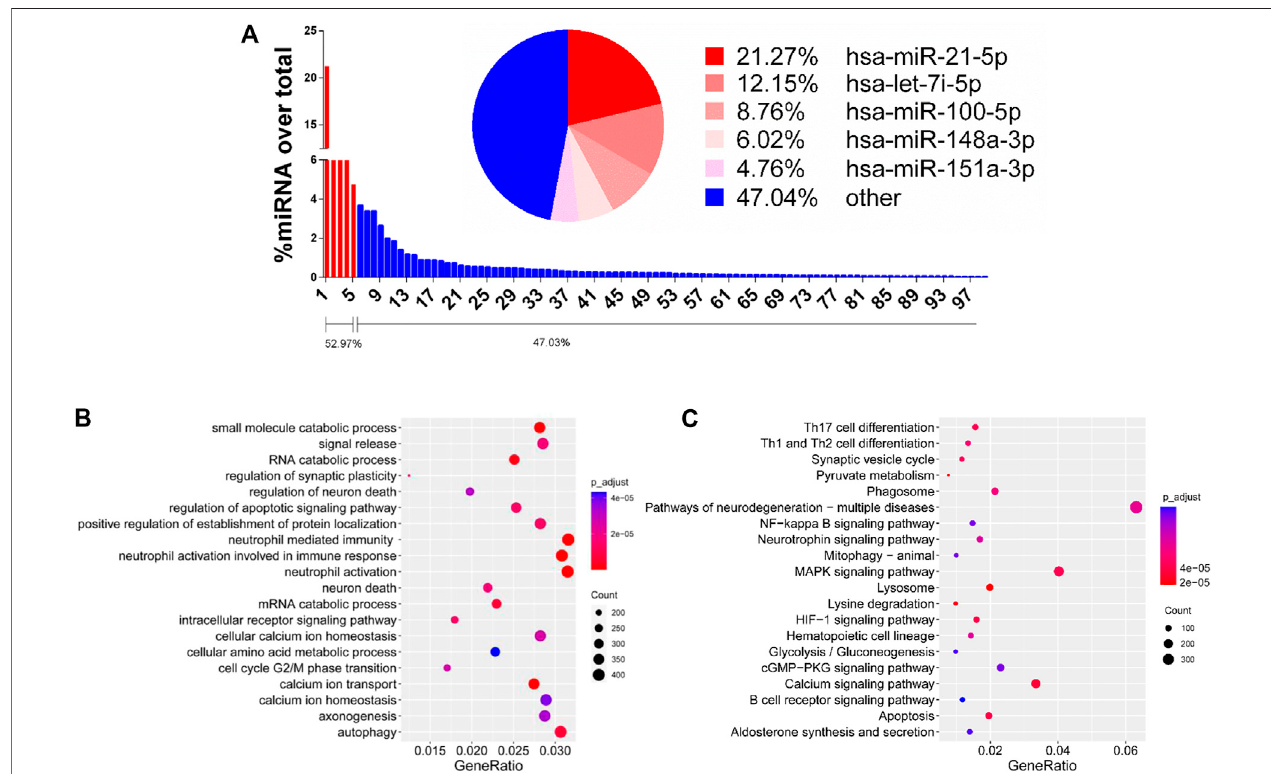
FIGURE 6 | Functional analysis of EVs/Exo-miRNAs. (A) Bar diagram showing miRNAs expressed in theen riched hRPC-sEVs. Left to right is showing high to low percentages. The pie chart shows the top fi ve miRNAs in hRPC-sEVs. Selected enriched GO biological processes (B) and KEGG pathways (C) for the top expressed miRNAs in hRPC-sEVs. The coloring of the q-values indicates the signi fi cance of the rich factor. The circle indicates the target genes that are involved, and the size is proportionaltothegenenumbers.The X -axisindicatestherichfactor,whichreferstotheratioofthenumberofgeneslocatedinthedifferentiallyexpressedgeneto the total number of the annotated genes located in the pathway. The Y -axis indicates the names of enriched pathways.